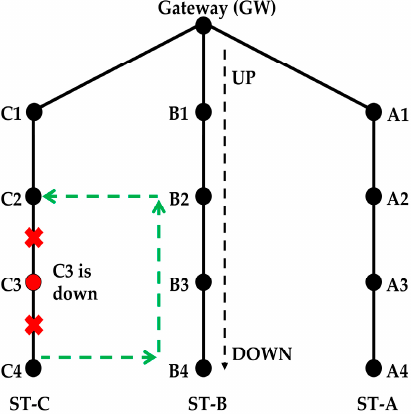
Figure 11. Alternative path when a node fails after the routing paths have been formed.